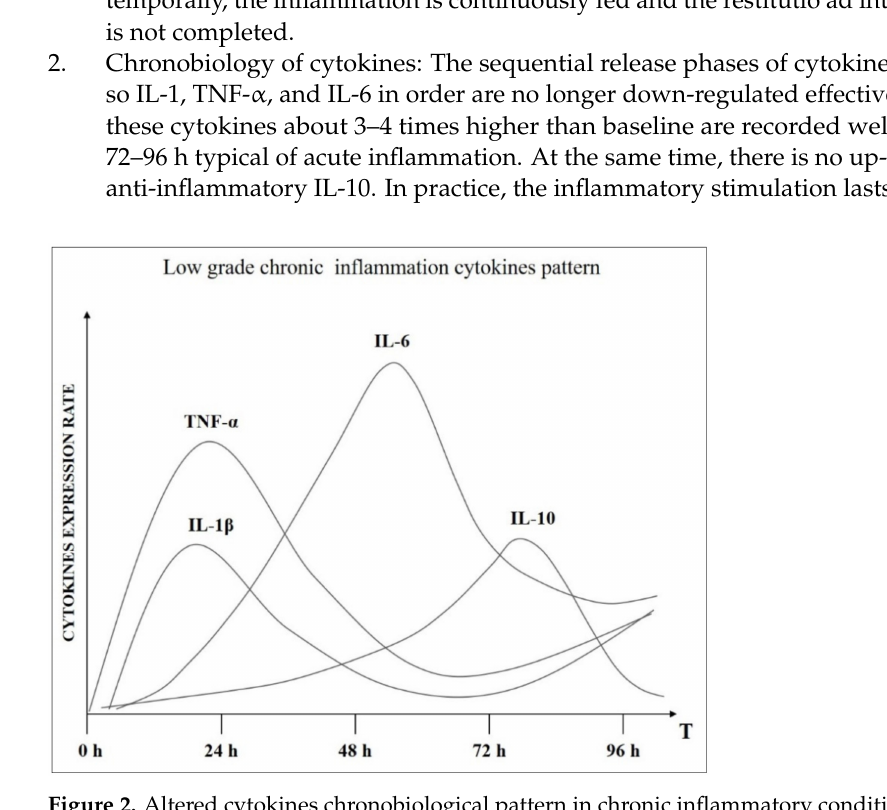
Figure 2. Altered cytokines chronobiological pattern in chronic inflammatory